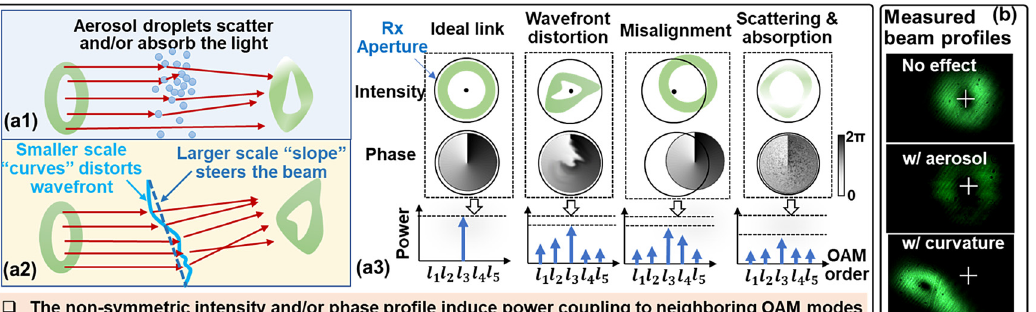
Figure 2: (a) The potential causes of modal power loss and power coupling under (a1) aerosol and (a2) curvature effects. (a3) The wavefront distortion, beam wandering, and spatially dependent scattering & absorption could affect the unique intensity and phase pro fi le of the received OAM beam. (b) The example images of OAM − 1 under aerosol and curvature effects. The cross mark in the image shows the beam center position under the no-effect case.